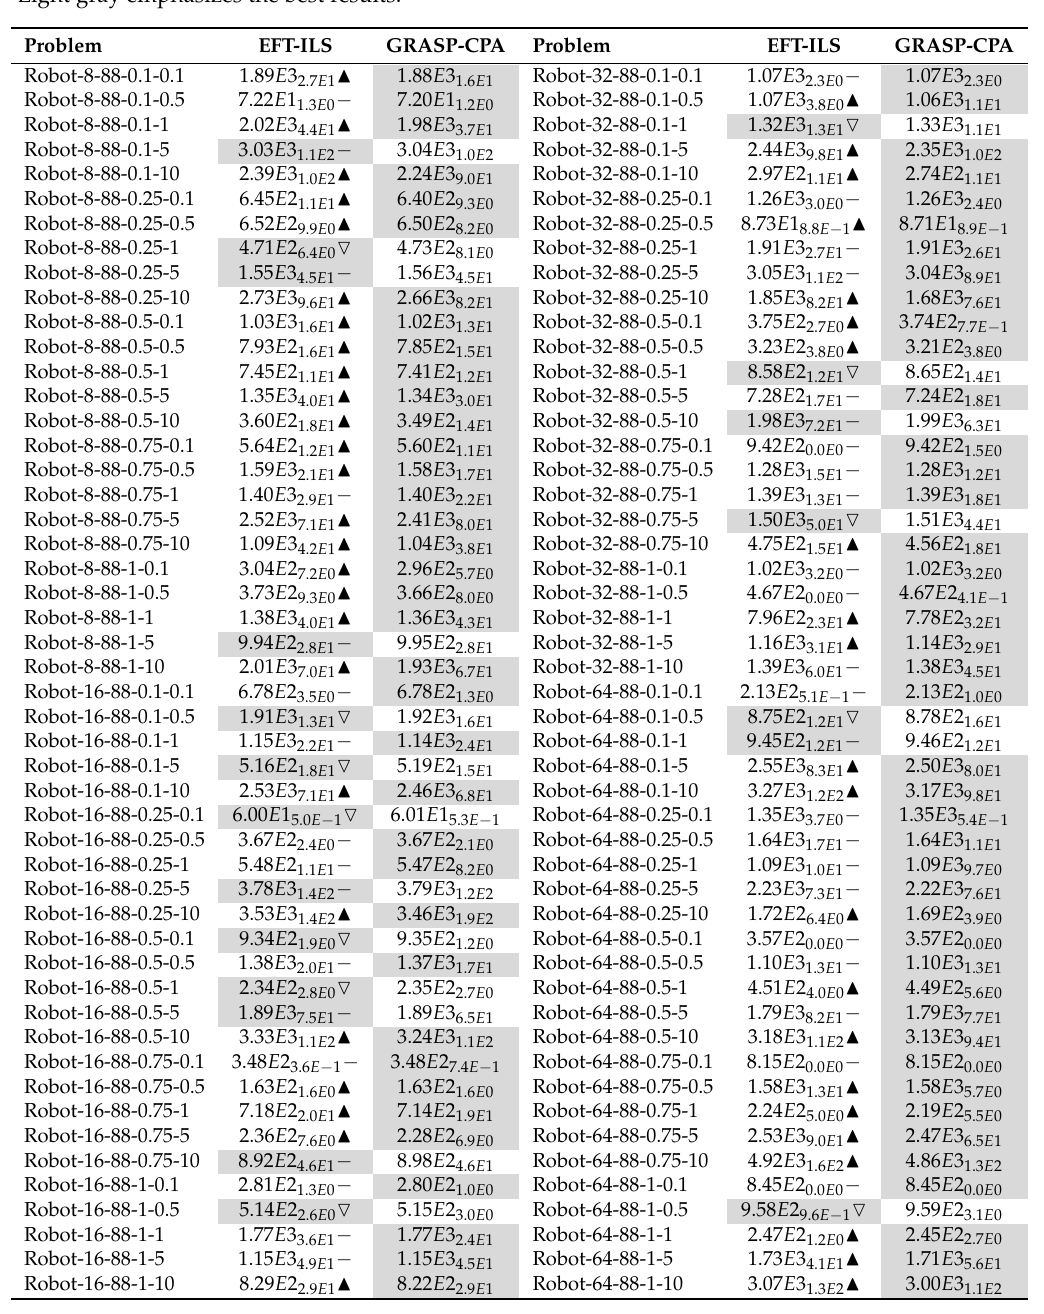
Table 6. Robot instances median and IQR of EFT-ILS and GRASP-CPA over 100 independent runs. Light gray emphasizes the best